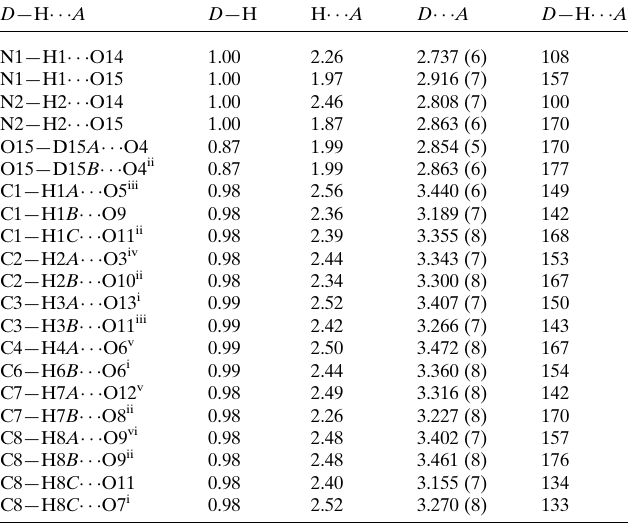
Table 1 Hydrogen-bond geometry (A˚ , (cid:5)